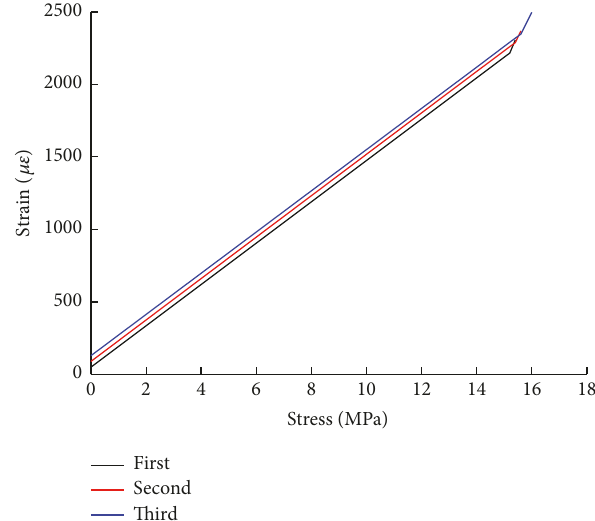
Figure 7: The stress-strain curve in three experimental procedures.